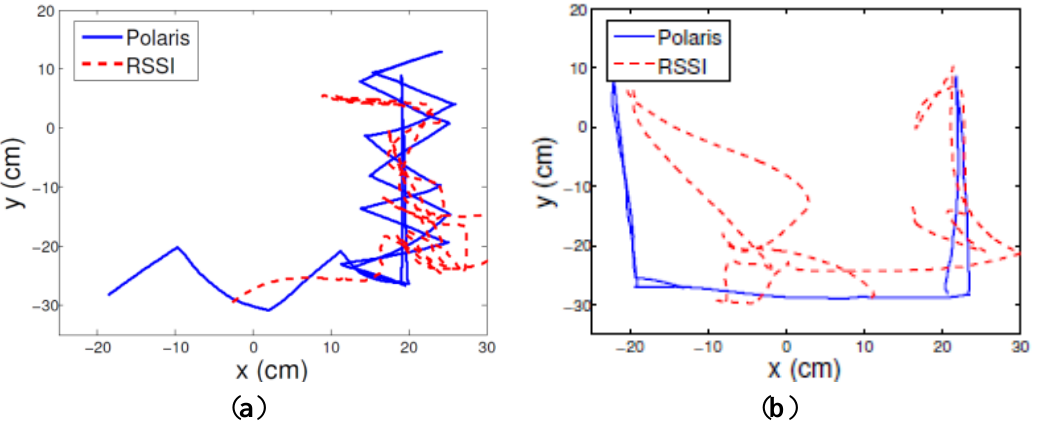
Figure 6. RSSI based location tracking compared to the optical reference for a hand moving in a zig-zag ( a ), and in a straight lines pattern ( b